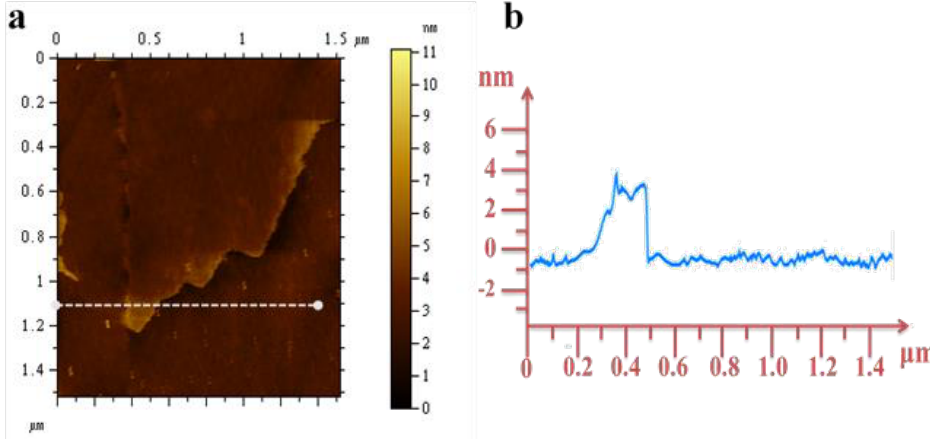
Figure 5. ( a ) Atomic force microscopy (AFM) image of MONs; ( b ) Height profile of the layer across the dotted line in panel ( a ).